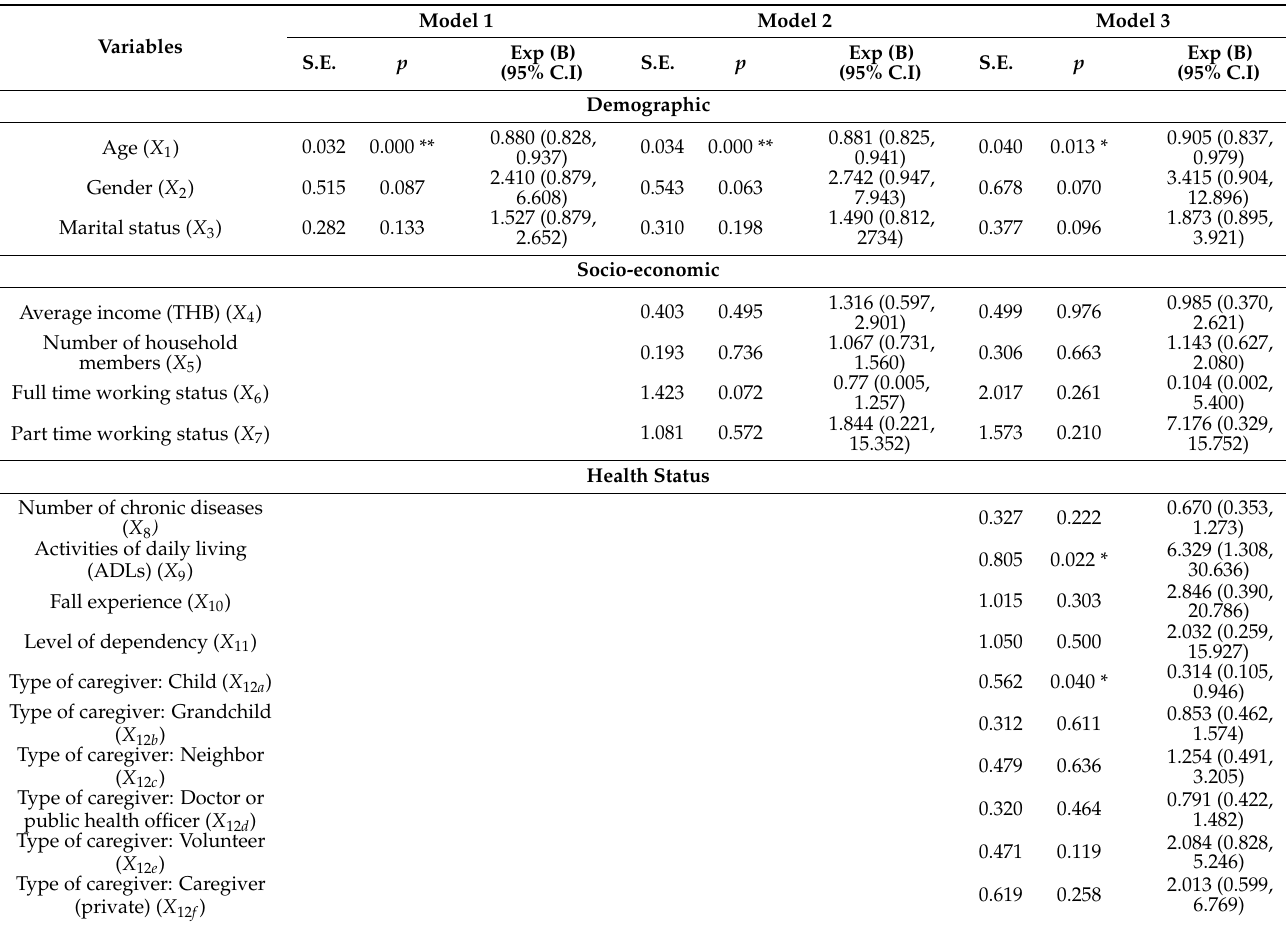
Table 6. Association between living alone and social